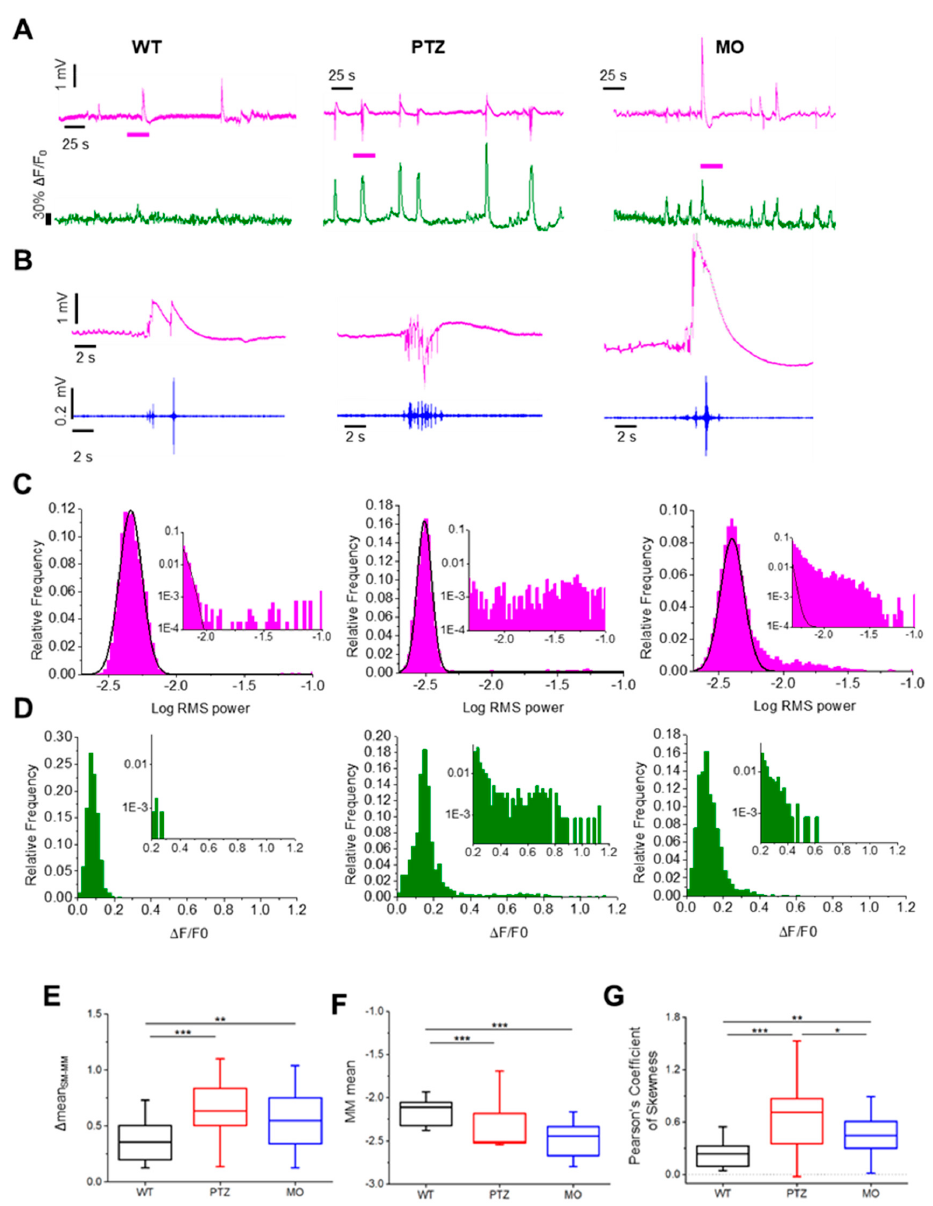
Figure 1 . Statistics of the local field potential (LFP) spectral power and Ca 2+ recordings in the three experimental groups. ( A ) Comparison of the statistics of LFP and whole brain Ca 2+ fluctuations recorded in the three experimental groups, wild-type (WT) as control zebrafish, PTZ (Pentylenetetrazol) after treatment with pentylenetetrazole and MO ( kcnj10a splice-morpholino) morphants of kcnj10a . The LFP transients in the PTZ and MO groups are associated to generalized positive fluctuation of the Ca 2+ . ( B ) Magnification of the LFP events is indicated by the magenta bars in panel A. The magenta traces show the full band data, while the blue traces show the data band passed in the 30–95 Hz range. ( C ) Statistical analysis of the electrophysiological activity. ( D ) Gaussian-like distribution of the ∆ F / F0 values in the three models. ( E ) Difference between the Secondary Mode (SM) mean and the mean of the Main Mode (MM) ( Δ meanSM - MM). ( F ) Comparison of the MM mean of the three different models. ( G ) Statistics of the Pearson’s coefficient of skewness of the distribution of the fluorescence fluctuations, Δ F/F0, integrated on the entire optical section. Statistics have been cumulated from 5 recordings for each larva for each condition (* p ≤ 0.05,** p ≤ 0.01, *** p ≤